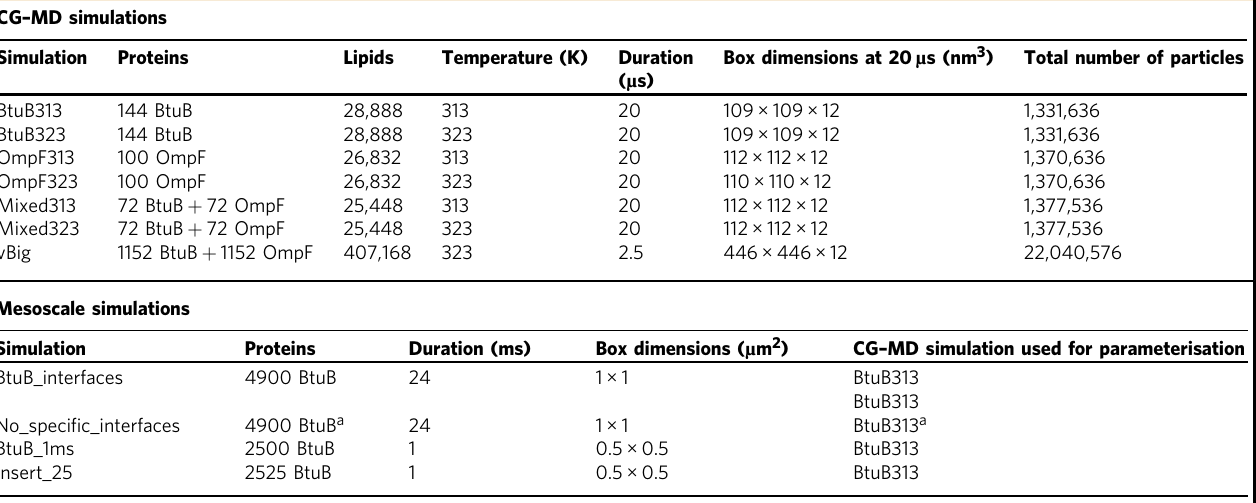
Table 1 Summary of CG – MD and mesoscale simulations performed